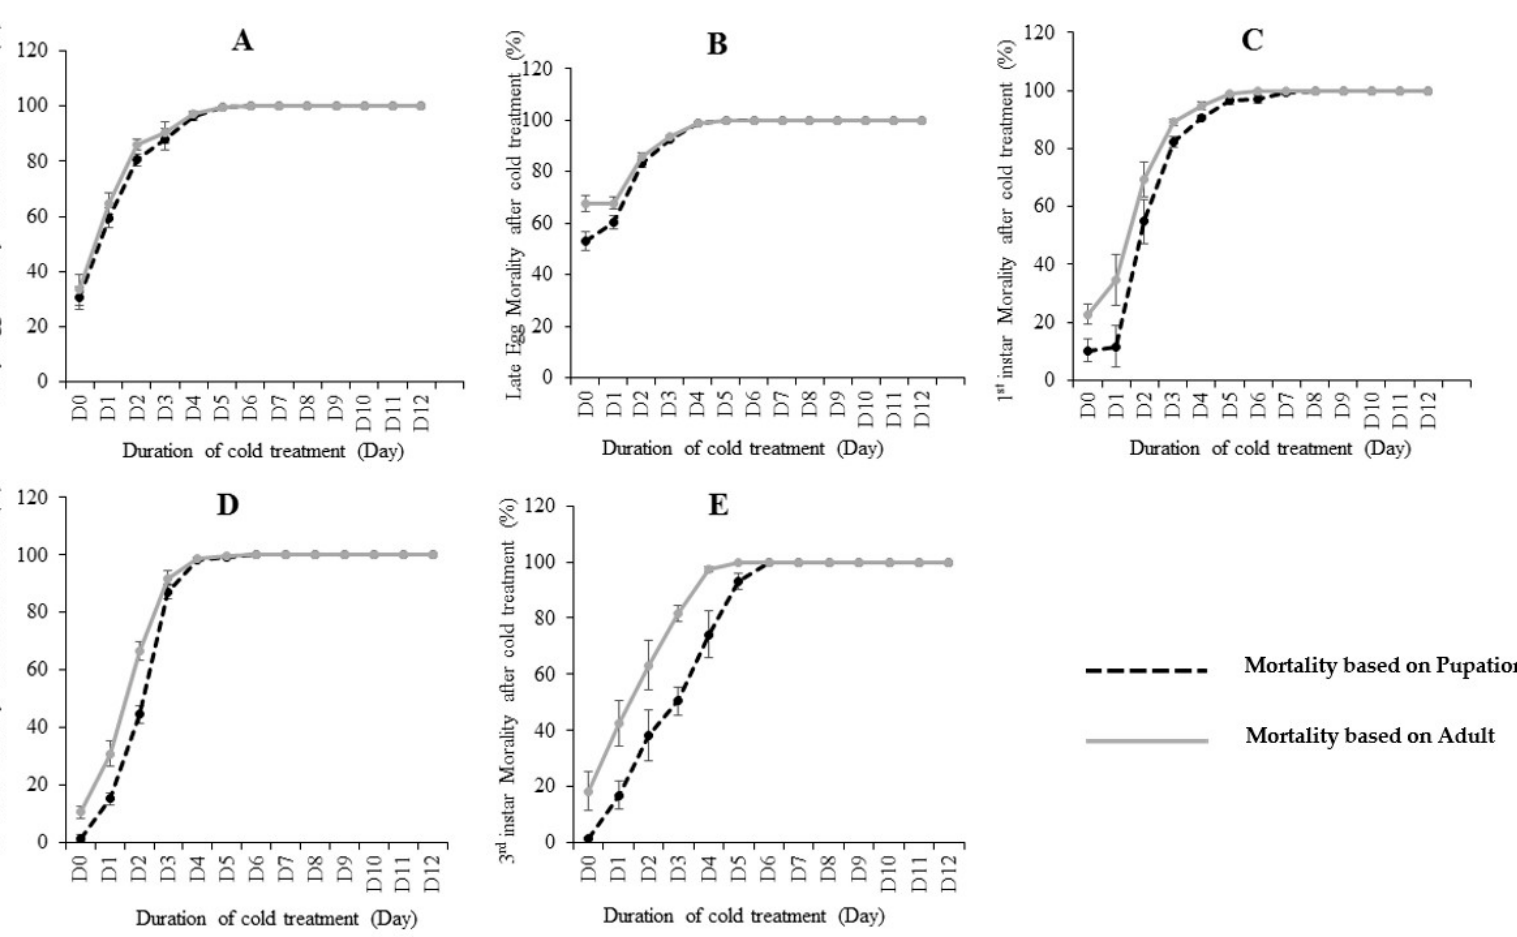
Figure 1. The mortality (%) calculated based on pupation and emerged adults at different immature stages including: early eggs ( A ), late eggs ( B ), 1st instar ( C ), 2nd instar ( D ) and 3rd instar ( E ) larvae of C. capitata fed on lab diet when subjected to various days of cold treatment at 0.0 °C. Error bar means standard error.